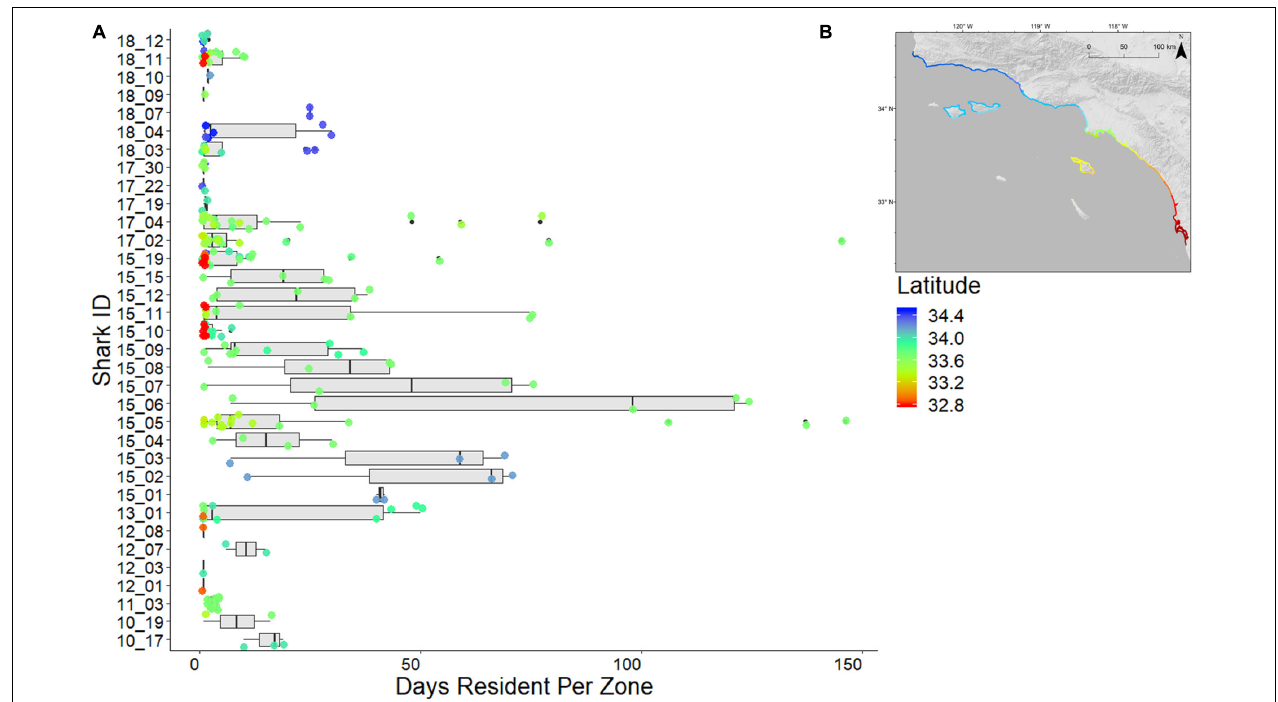
FIGURE 6 | (A) Resident days per zone per individual shark. Boxes indicate interquartile range of residency values of individual sharks, box lines indicate medians, whiskers indicate minimum, and maximum residency values (excluding outliers). Colored circles represent latitude for each zone resident by a shark, referenced by inset map (B)